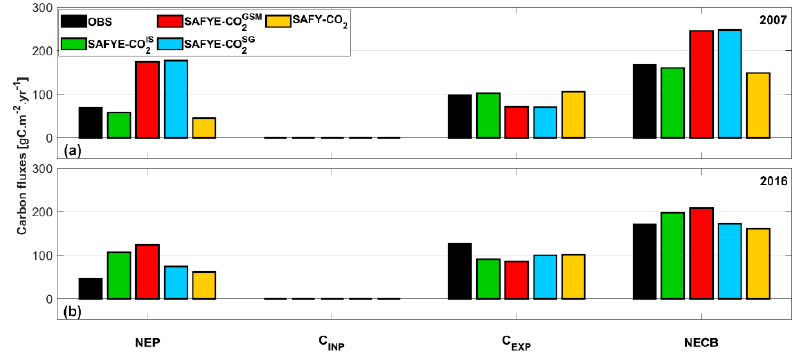
Figure 7. Components of the net ecosystem carbon budget for CY-07 ( a ) and CY-16 ( b ) at FR-Aur for the SAFYE-CO 2IS (green bars), SAFYE-CO 2GSM (red bars), SAFYE-CO 2SG (blue bars), and SAFY-CO 2 (orange bars) models compared to the observed value (black